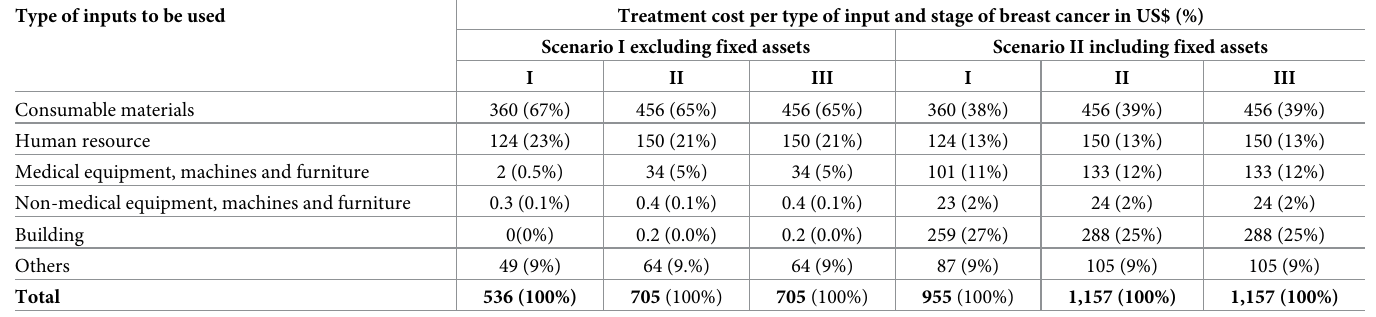
Table 4. Cost of breast cancer treatment by type of input (April 21,